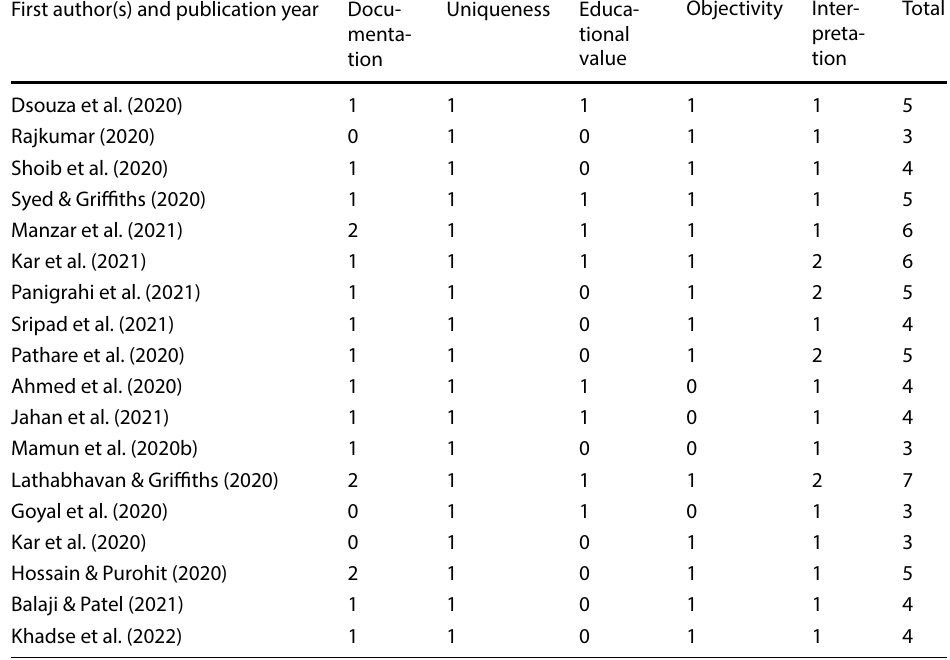
Table 2 Quality assessment of the included